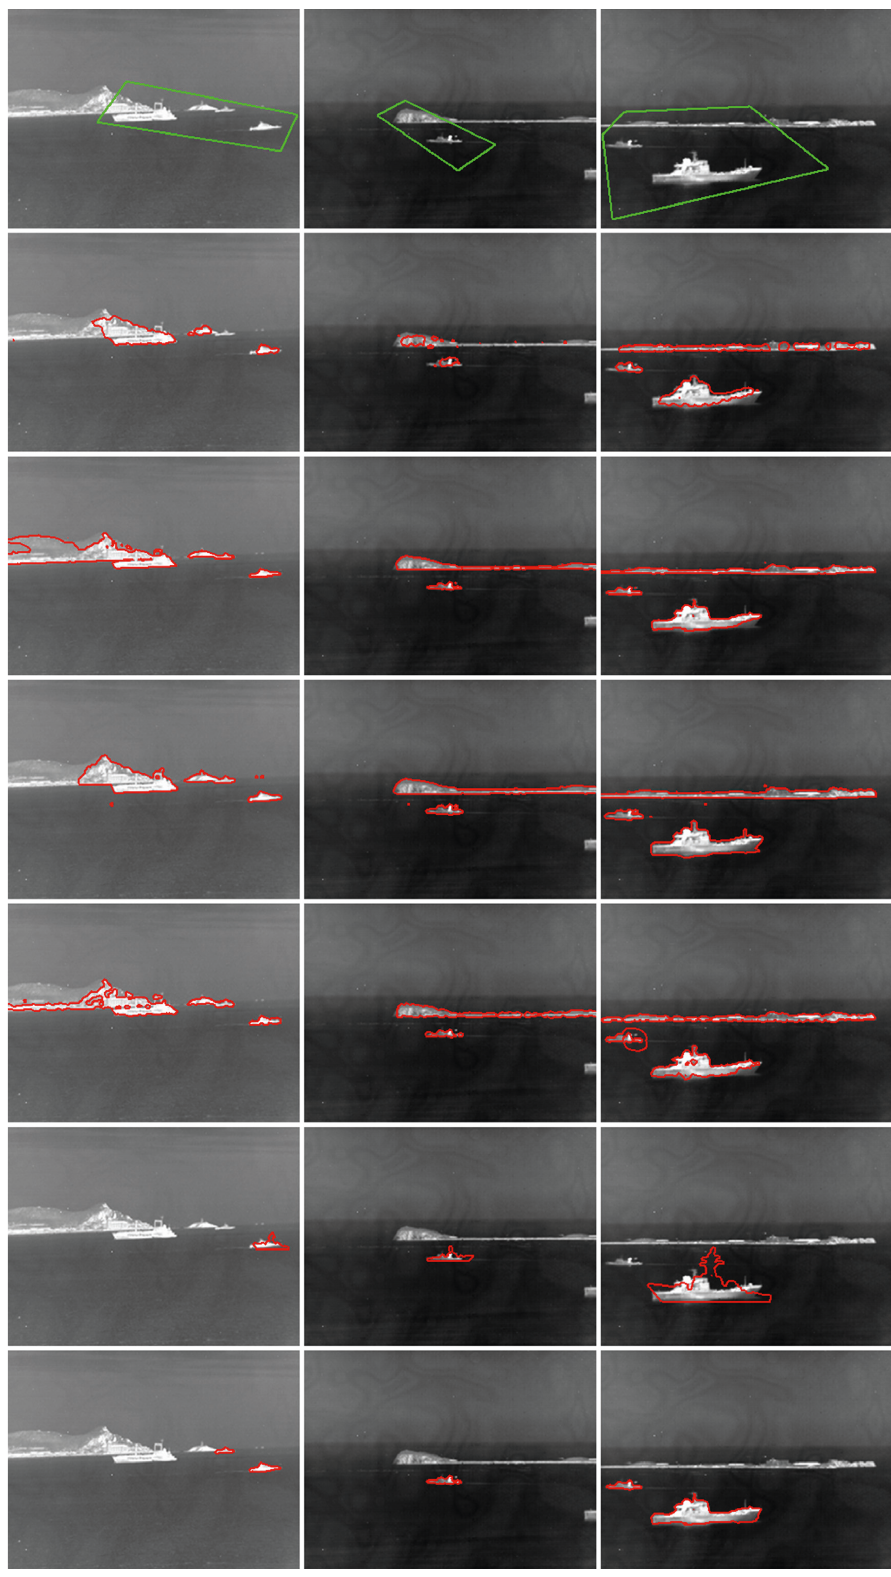
Figure 5: A set of comparison segmentation experiments on real infrared ship images in the case of multiple shape priors. The first row is the input images along with initial contours. The second to seventh rows are the segmentation results by using the LSEWR, RSF, LGDF, LIF, CREMERS, and our SP-LEM models, respectively. The relevant task parameters are N � 2, μ � 0 . 05, Δ t � 4 . 5, σ � 3 . 5, and ε �